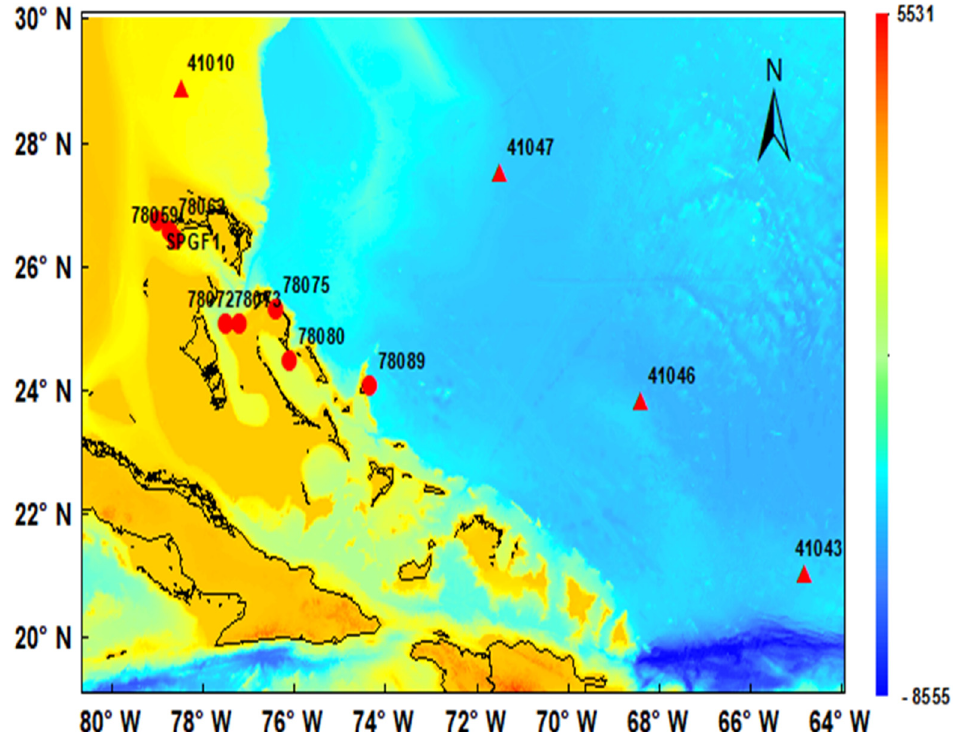
Figure 3. Topographic/bathymetric map (shading, units: m) of the Caribbean Sea showing the location of National Buoy Data Center buoys (triangles) and C-MAN and operational Bahamas Department of Meteorology automatic weather stations (circles) in or near The Bahamas.